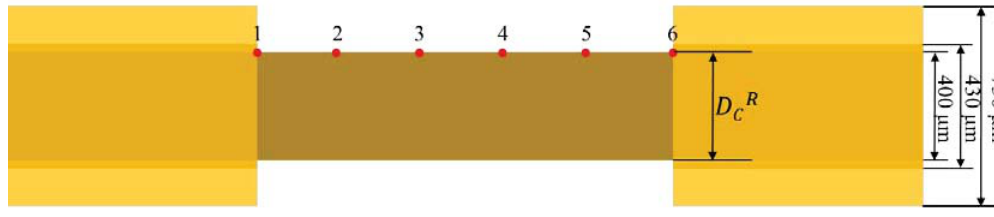
Figure 9. Schematic of the measurement